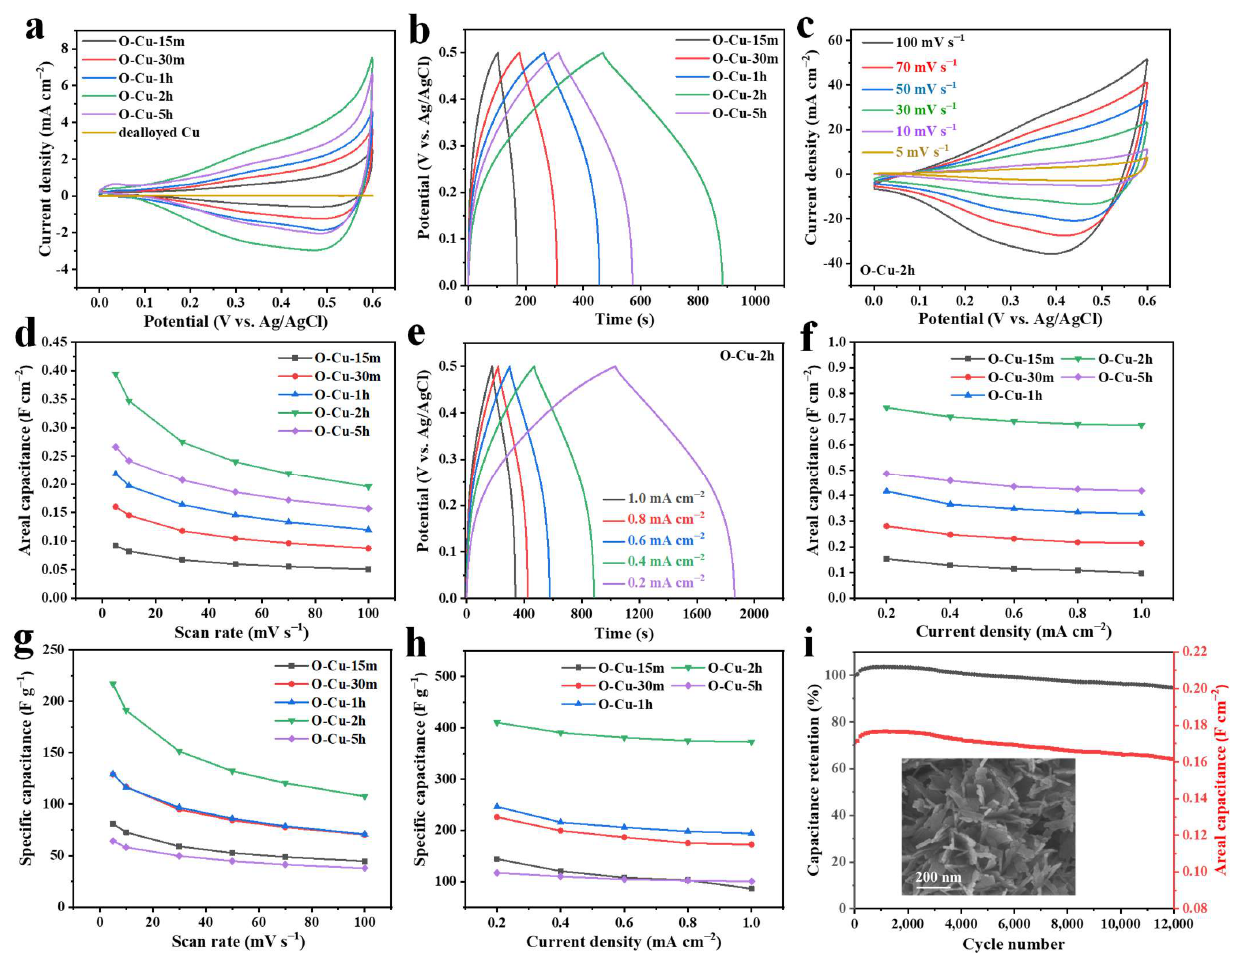
Figure 5. ( a ) Electrochemical performance of O-Cu-15m, O-Cu-30m, O-Cu-1h, O-Cu-2h, and O-Cu-5h in 1 M KOH. ( a ) CV curves at 5 mV s − 1 . ( b ) GCD profiles at 0.4 mA cm − 2 . ( c ) CV curves of O-Cu-2h at various scan rates ranging from 5 to 100 mV s − 1 . ( d ) Areal capacitance as a function of scan rate. ( e ) GCD profiles of O-Cu-2h at different current densities. ( f ) Areal capacitance versus the current density. ( g ) Specific capacitance normalized to the Cu x O mass as a function of scan rate. ( h ) Specific capacitance normalized to the Cu x O mass versus the current density. ( i ) Cyclic performance of O-Cu-2h measured at 100 mV s − 1 . The inset is the SEM image of O-Cu-2h after 12,000 cycles.